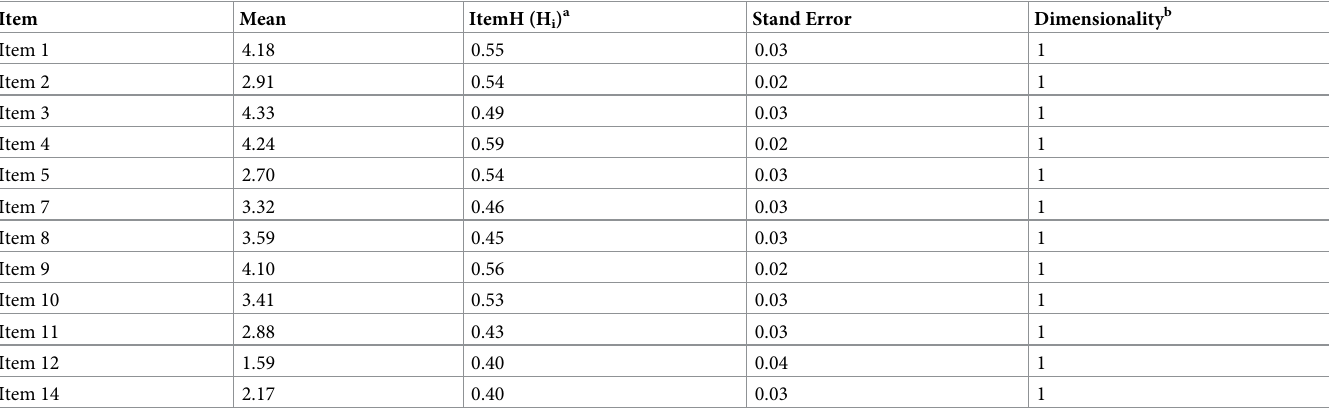
Table 4. Loevinger’s coefficient for scalability assumption test from Mokken